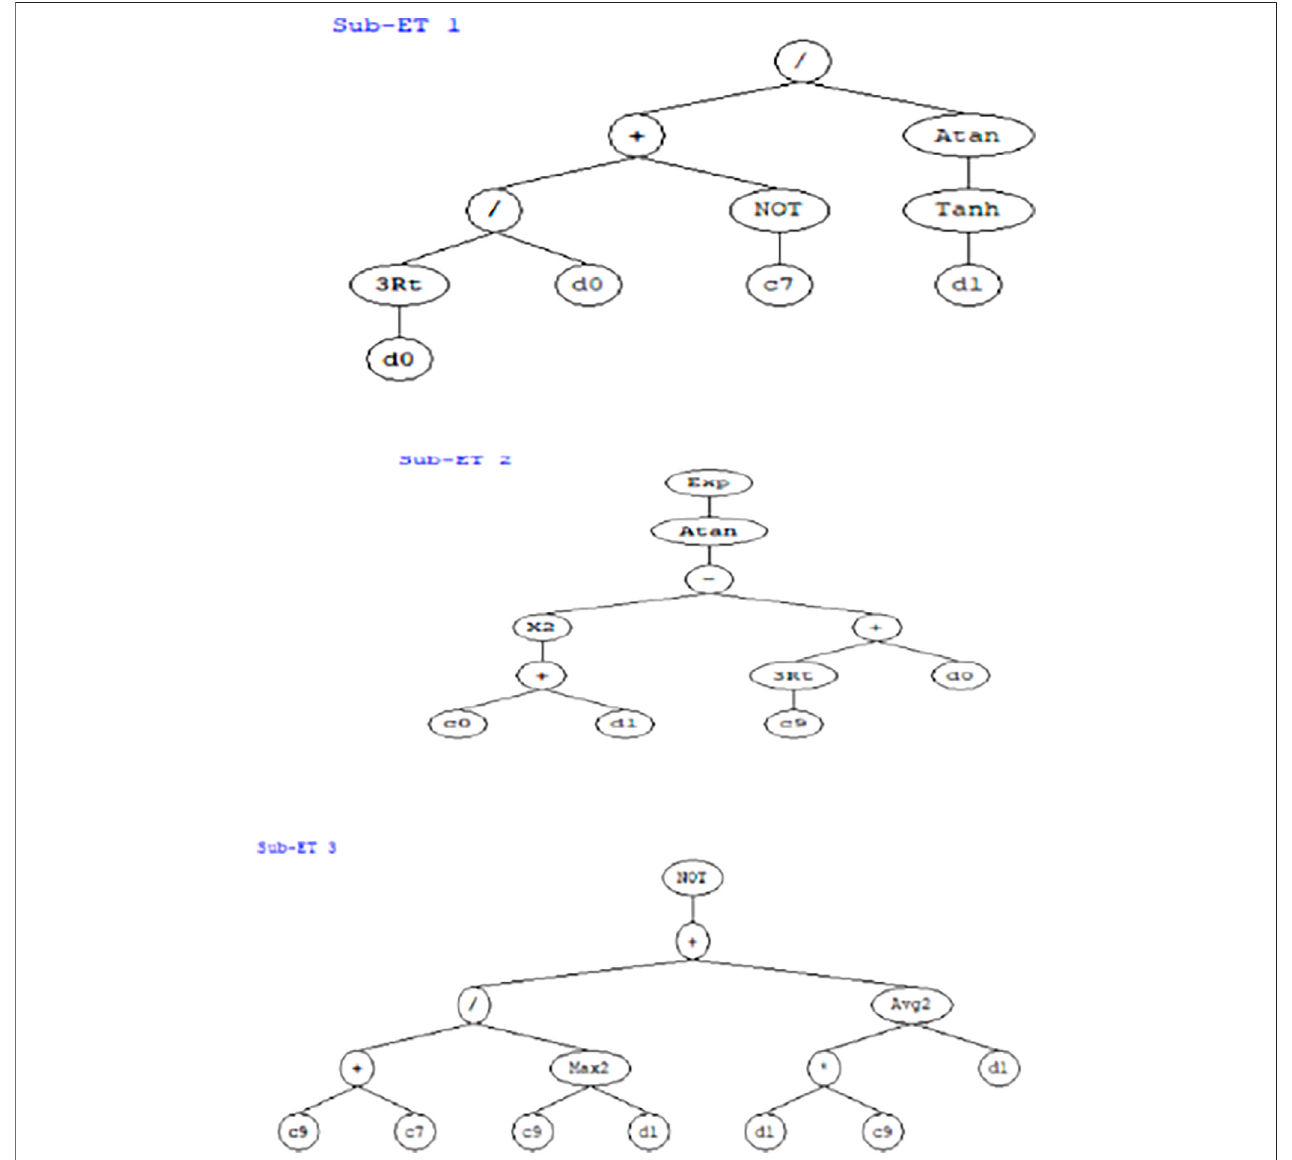
FIGURE 5 | The expression tree of IRI was obtained from the genetic programing software Genexpro 5.0 (d1: PSR, d0: PCI).